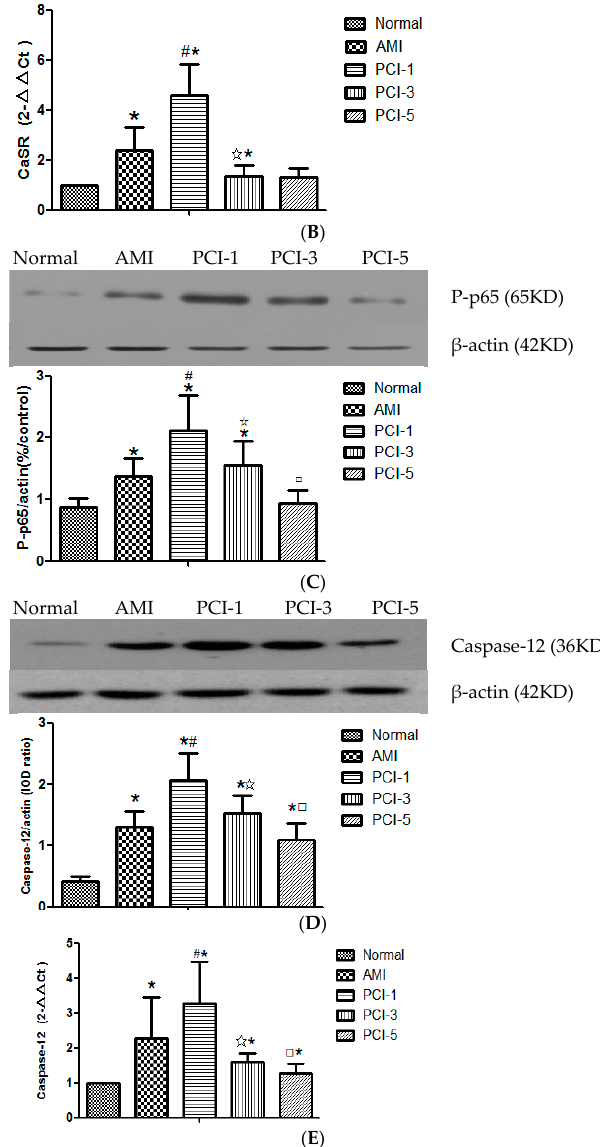
Figure 1. Protein and mRNA expressions of calcium-sensing receptor (CaSR) ( A , B ) and Caspase12 ( D , E ) in T lymphocytes and the phosphorylation level of NF- κ B pathway protein ( C ) during the different stages in acute myocardial infarction (AMI). Protein expressions in T lymphocytes were tested by Western blot and qRT-PCR quantitative analysis ( n = 20). Expression protein was quantified by densitometry. Expression results are representative of five experiments. * p < 0.05 vs. normal group; # p < 0.05 vs. AMI group; ☆ p < 0.05 vs. PCI-1 group; □ p < 0.05 vs. PCI-3 group.